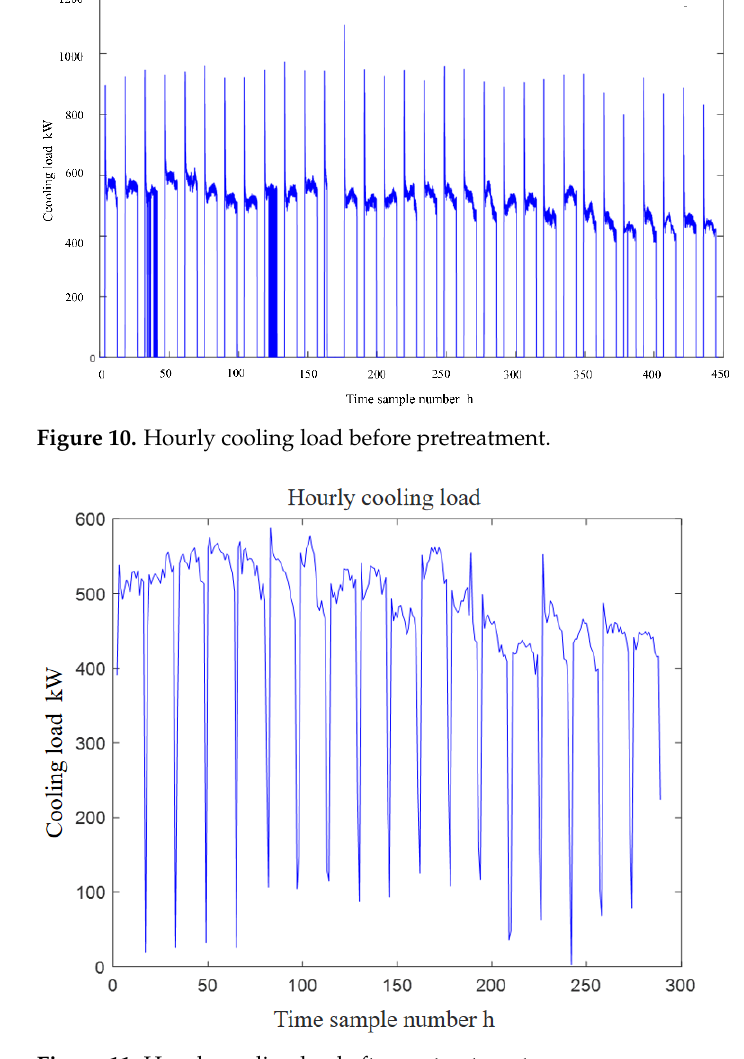
Figure 11. Hourly cooling load after pretreatment.